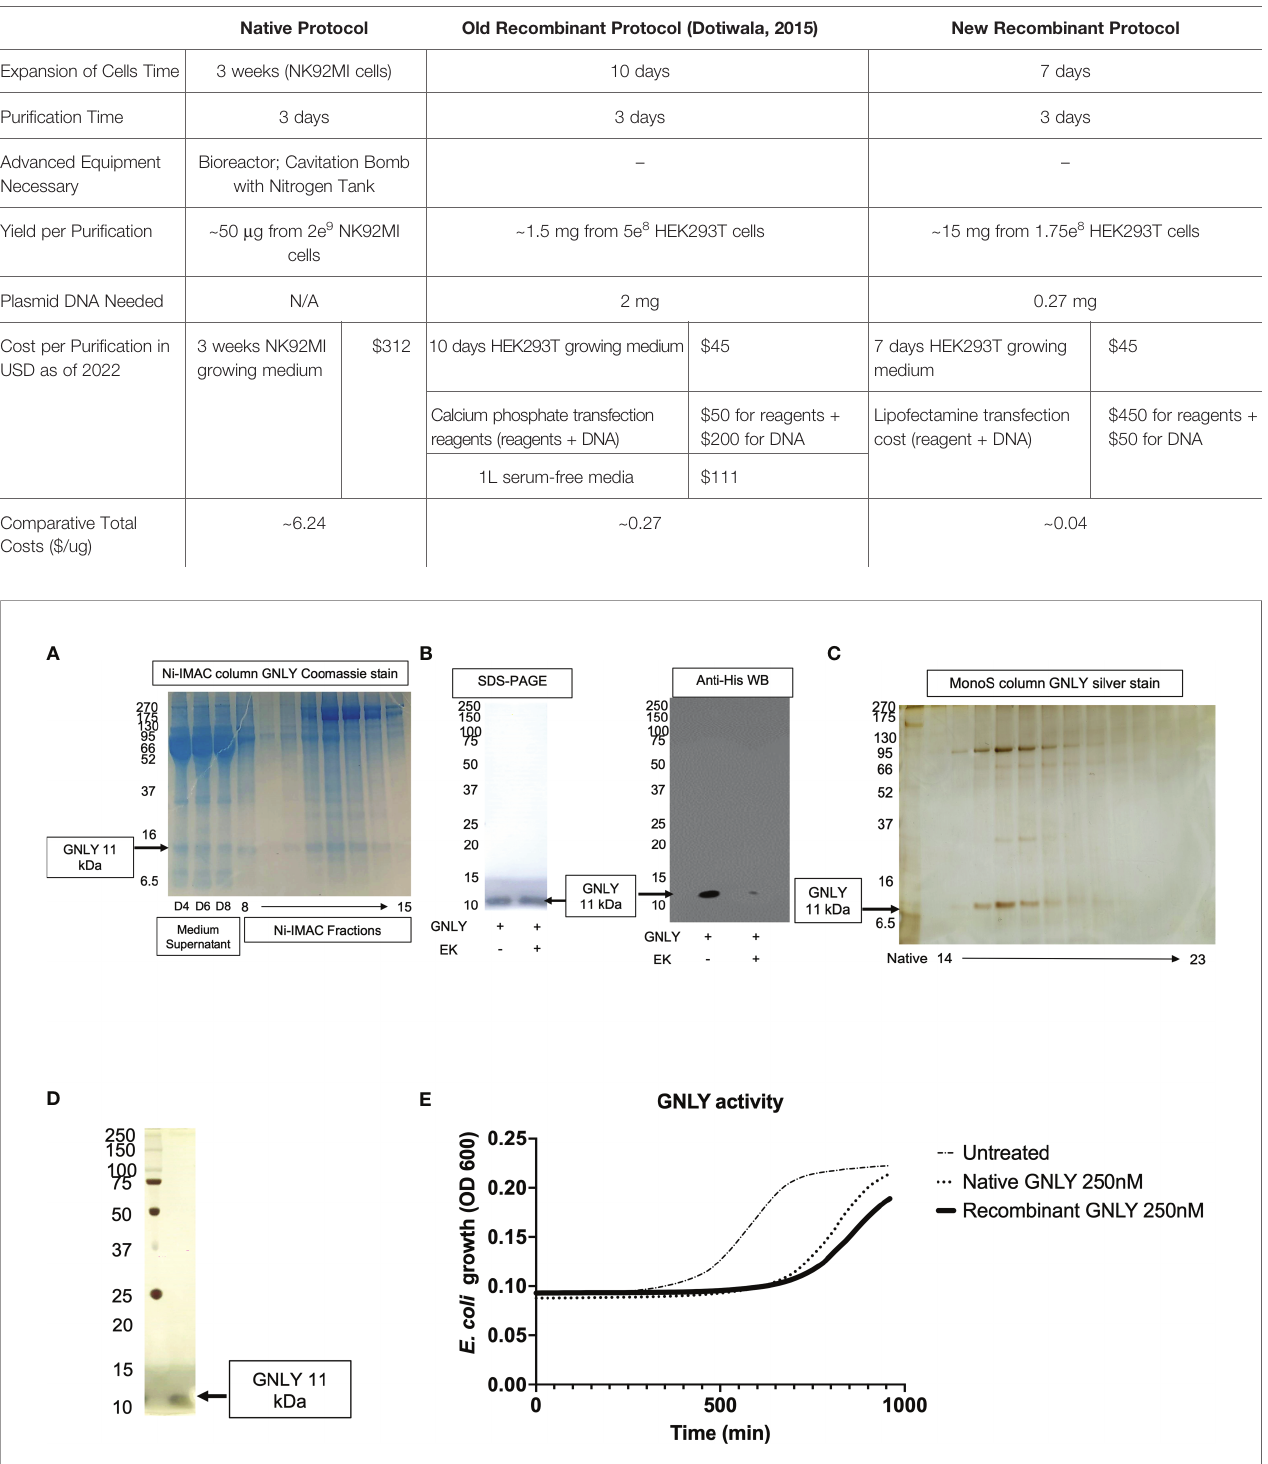
TABLE 2 | Comparisons between native, old recombinant (38), and new recombinant protocols.